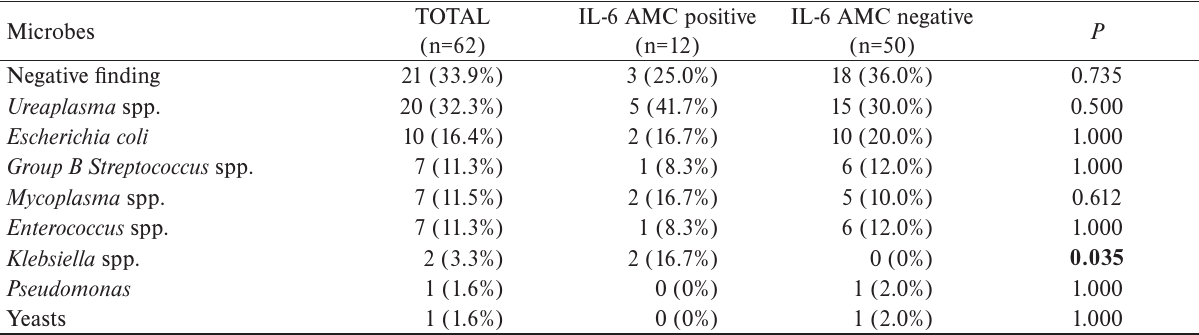
Table 2. Microbes identified in the cervical swabs in women with PPROM.